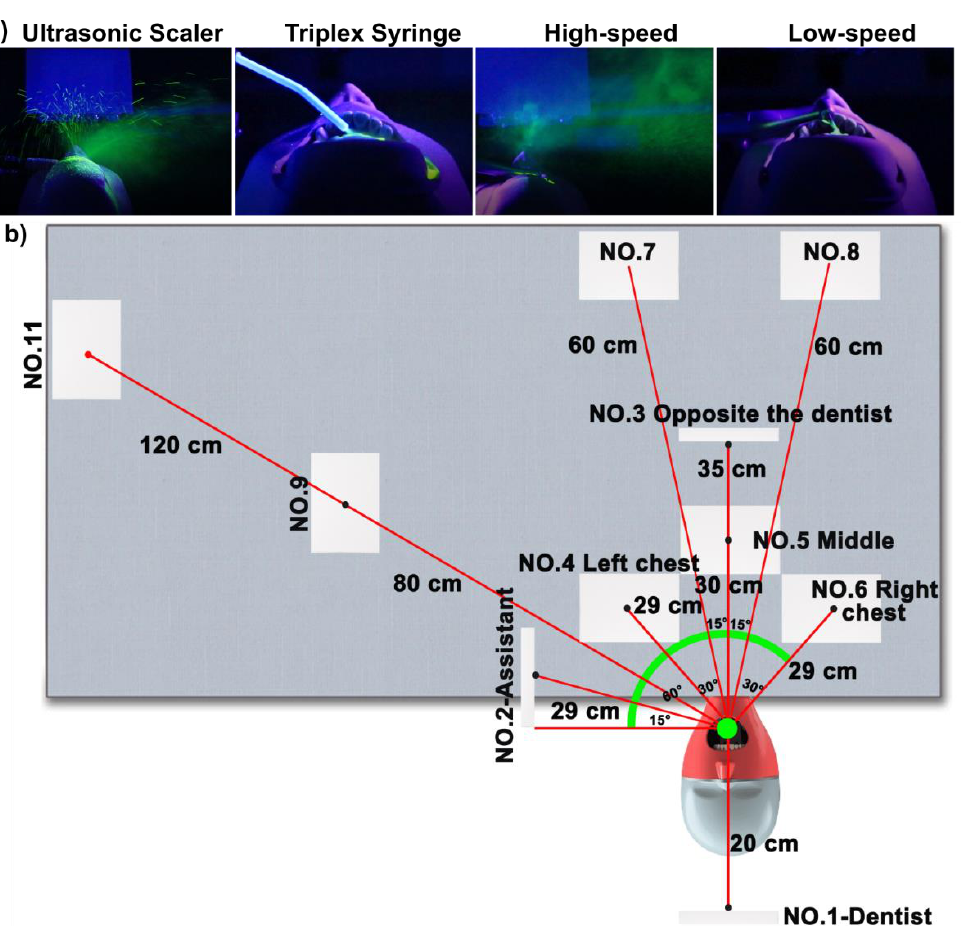
Figure 1. Representative images of liquid particles and experimental design for liquid particle collection. ( a ) Examples of the position of dental instruments. The fluorescein tracer is seen as green because of illumination with 405 nm violet light using an LED torch. The liquid generated by the ultrasonic scaler, triplex syringe, high-speed handpiece and low-speed handpiece can be seen. ( b ) A schematic diagram of the positions for splatter and aerosol collection at 10 different locations (No. 1–10). The angular positions in degrees were calculated relative to the sagittal plane of the manne- quin.